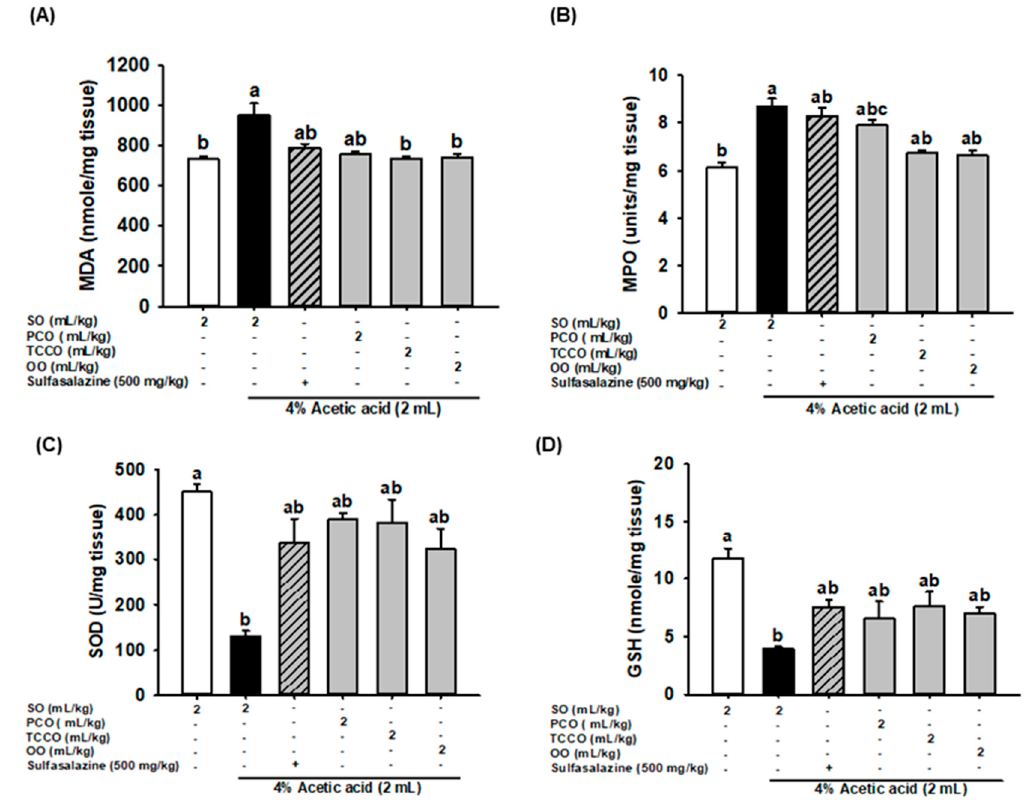
Figure 4. Effects of SO, PCO, TCCO, and OO on the levels of ( A ) MDA, ( B ) MPO, ( C ) SOD, and ( D ) GSH in the colonic mucosa of Sprague–Dawley rats with AA-induced colitis. The animals received oral administration of SO, PCO, TCCO, or OO for 3 weeks, and then, AA was administered intrarectally for induction of colitis (except in the normal control group). Sulfasalazine (SASP) was used as a positive control after colitis was induced using AA. The rats were sacrificed on day 3, and their colon tissues were excised. The results are expressed as the mean ± SEM ( n = 6). Values assigned different letters are significantly different at p < 0.05, which was determined using Duncan’s multiple range test. SO, 2 mL/kg of body weight (BW) of soybean oil; AA, 2 mL of 4% of AA; SASP, 500 mg/kg BW of sulfasalazine; PCO, 2 mL/kg BW of C. oleifera oil; TCCO, 2 mL/kg BW of C. brevistyla oil; and OO, 2 mL/kg BW of olive oil. SOD, superoxide dismutase; MPO, myeloperoxidase; GSH, glutathione; MDA, malondialdehyde.